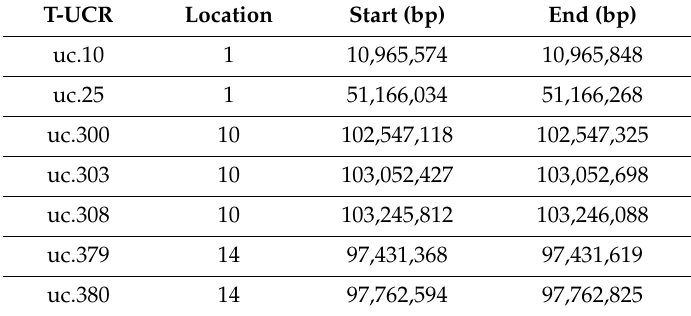
Table 2. A list of T-UCRs correlated with DNA copy number changes in neuroblastoma patients.